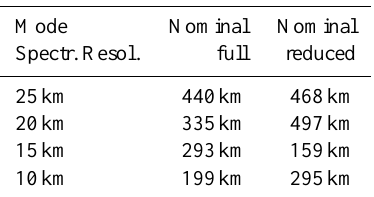
Table 4. Horizontal information smearing (full width at half maxi- mum of the horizontal component of the 2-D averaging kernel) for